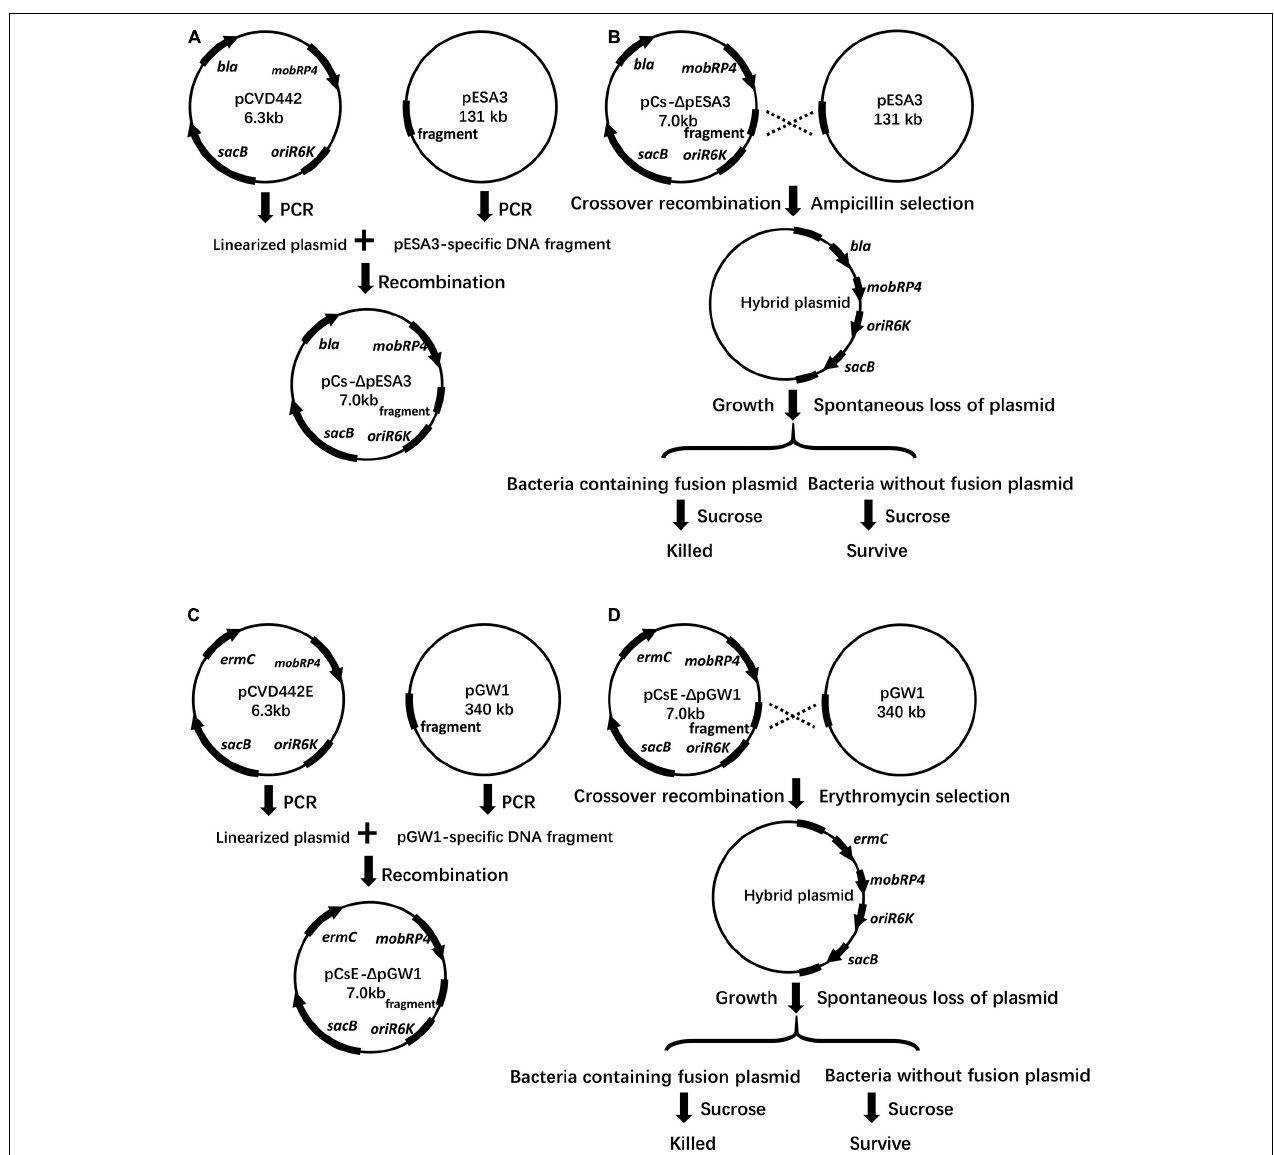
FIGURE 1 | Schematic representation of vectors, crossover recombination, plasmid hybrid, and sucrose selection. (A) The vector pCs- (cid:49) pESA3 is shown with the pESA3-specific hybrid fragment and gene orientation of the ampicillin resistance ( bla ), pir replication initiator (oriR6K), sucrose sensitivity marker ( sacB ) and broad-host-range mobilizable region (mobRP4). pCVD442 was linearized by PCR and ligated with a pESA3-specific DNA fragment, resulting in the plasmid pCs- (cid:49) pESA3. (B) The plasmid pCs- (cid:49) pESA3 was extracted from S17–1 lambda pir E. coli and transformed into C. sakazakii BAA-894. The integration of pCs- (cid:49) pESA3 into the endogenous plasmid pESA3 of C. sakazakii BAA-894 by crossover recombination resulted in the strain C. sakazakii BAA-894 containing the hybrid plasmid. Growth of the plasmid crossover recombinants allowed for the spontaneous loss of the hybrid plasmid in a small fraction of the bacteria. Exposure to sucrose resulted in selective killing of the bacteria containing the hybrid plasmid that retained the sucrose sensitivity marker sacB , and the surviving bacteria cured of the plasmid were identified by testing for ampicillin susceptibility and via plasmid-specific PCR. (C) The vector pCs- (cid:49) pGW1 was similar to pCsE- (cid:49) pESA3, but ermC was used instead of bla due to the existence of the cephalosporin resistance gene bla DHA - 1 in pESA3, and the fragment was amplified from pGW1. (D) The procedure was the same as that described in (B) , except the endogenous plasmid to be deleted was pGW1, and the integrated suicide plasmid was pCs- (cid:49) pGW1. (B,D) The hybrid plasmid was used for plasmid complementation in the plasmid-cured